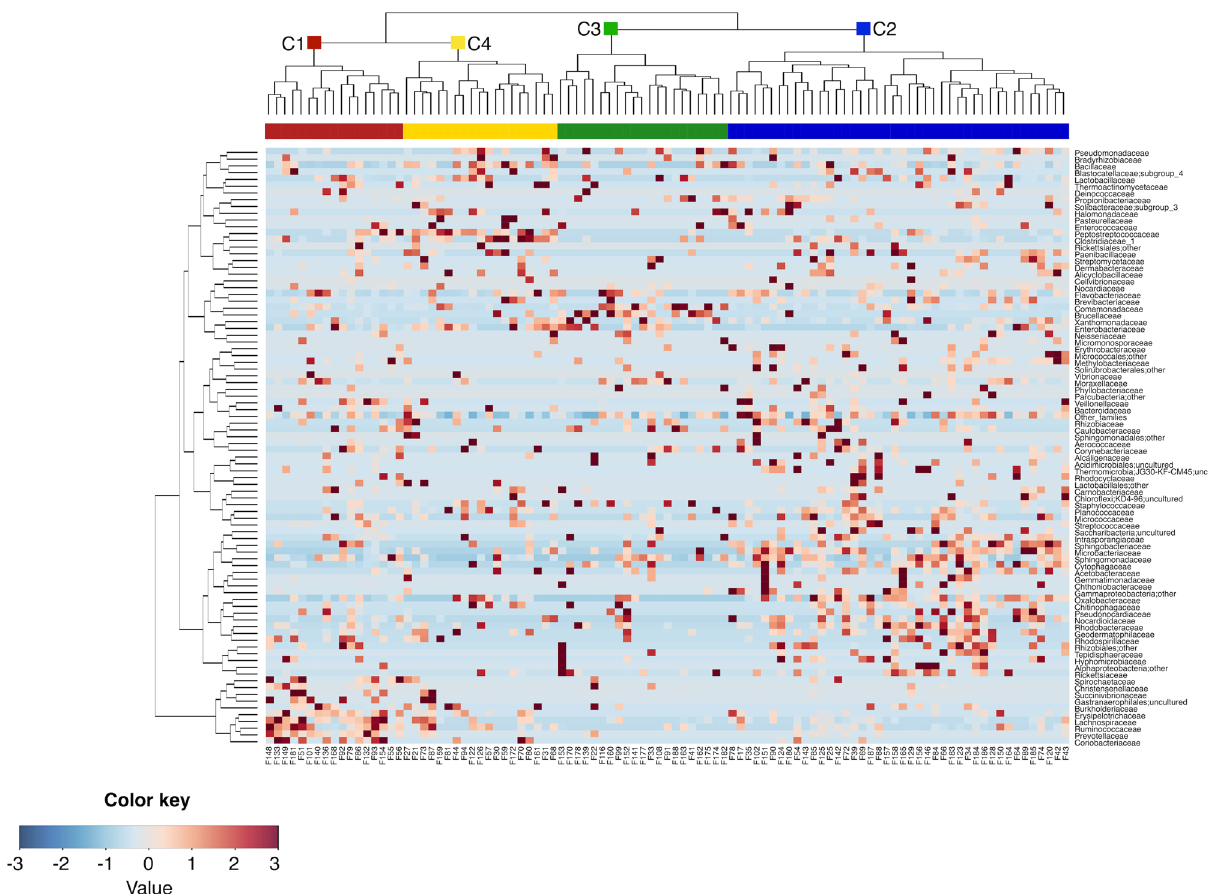
Figure 3. Family-level clusters of the airborne microbiome. Hierarchical Ward-linkage clustering based on the Spearman correlation coefficients of the proportion of families in the AM samples. Only families with relative abundance > 2% in at least 3 samples were retained. The four identified clusters (FDR-corrected permutation test with pseudo-F ratio, p-value ≤ 0.001) are labelled in the top tree and highlighted by different coloured squares (red, blue, green and yellow for the clusters C1, C2, C3 and C4,